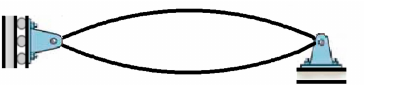
Figure 21. Leading hinge of the beam moving inside a vertical constrained groove.